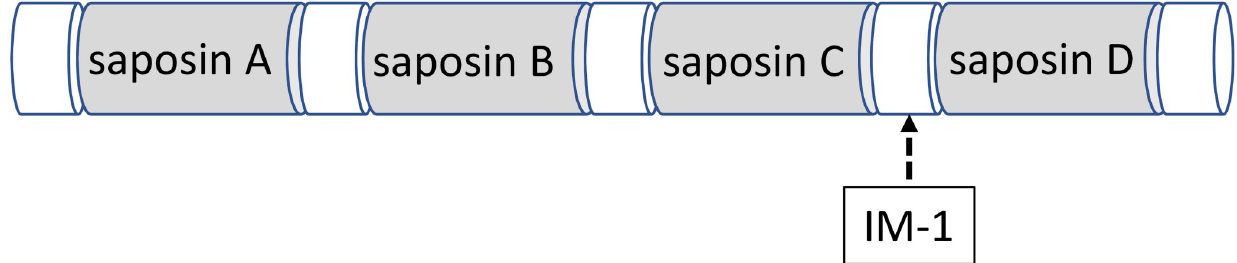
Fig 1. Structure of PSAP and the IM-1 antibody. An anti-rat PSAP-specific antibody (IM-1) was prepared against the proteolytic portion (the intermediate portion between saposins C and D) of PSAP.